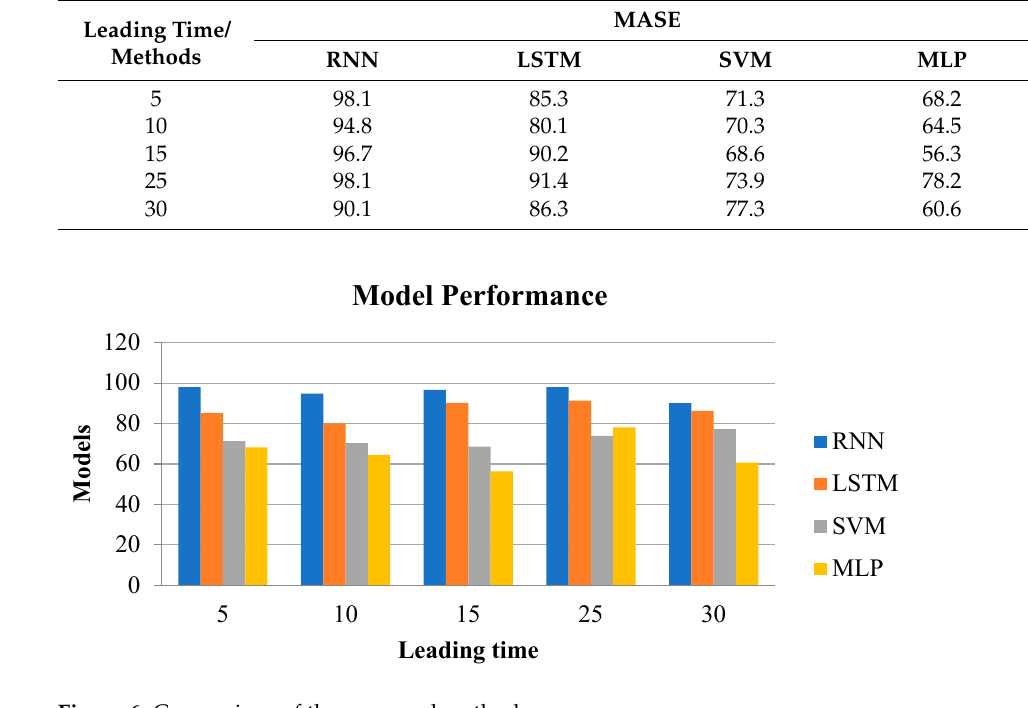
Figure 6. Comparison of the proposed method.